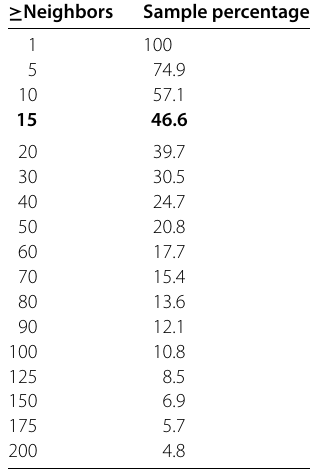
Table 2 Percentage of sample remaining after applying a minimum number of neighbors threshold ≥